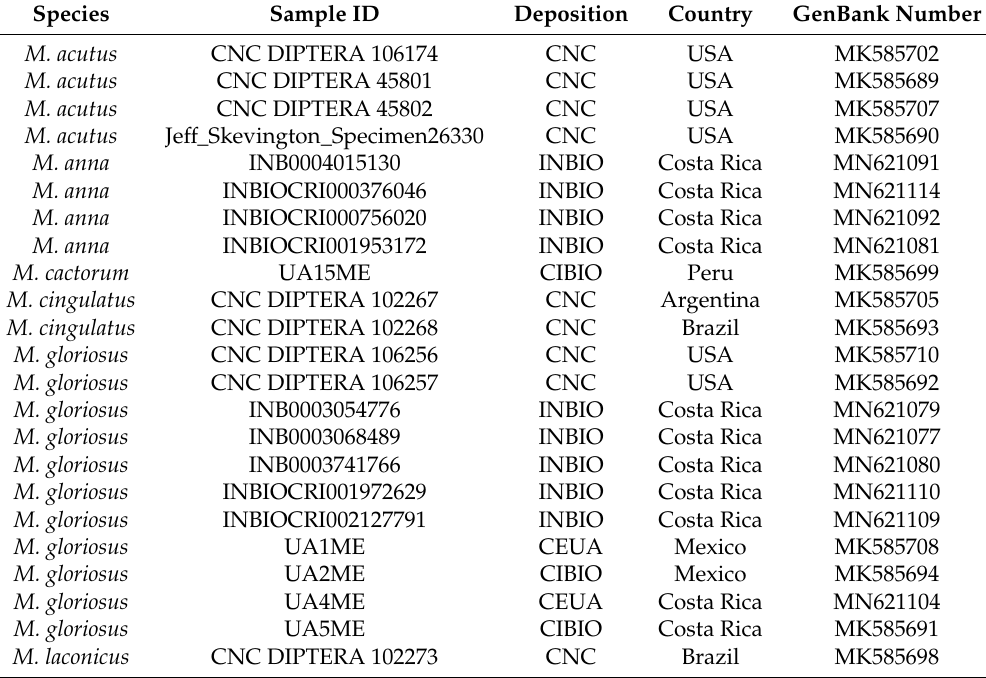
Table 2. Meromacrus and outgroup specimens used for DNA barcode analysis. All data are available from the public dataset on BOLD: Meromacrus revision